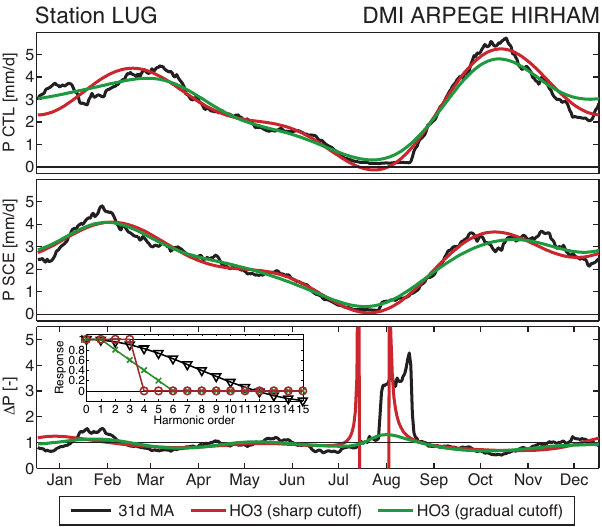
Fig. 7. Illustration of the overshooting problem for the example of the GCM-RCM DMI-ARPEGE-HIRHAM at the station LUG. Annual cycle of P in the CTL (top) and SCE 2070–2099 (middle) period as well as its climate change signal (bottom) as estimated by use of different filters. The inset shows the response function of the spectral filters.